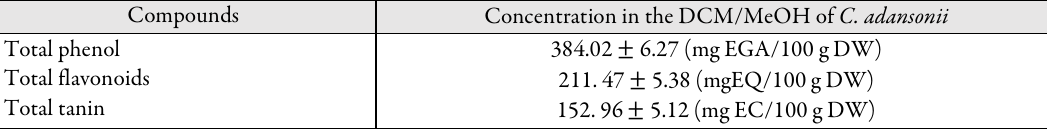
Table 2. Total phenol, total flavonids and total tanin quantity of the DCM/MeOH extract of C. adansoni Compounds Concentration in the DCM/MeOH of C. adansonii Total phenol 384.02 (cid:1) 6.27 (mg EGA/100 g DW) Total flavonoids 211. 47 (cid:1) 5.38 (mgEQ/100 g DW) Total tanin 152. 96 (cid:1) 5.12 (mg EC/100 g DW) Results are expressed as mean ± MSE.mgEGA/100 g DW: milligram equivalent gallic acid per 100 g Dry Weight; mg